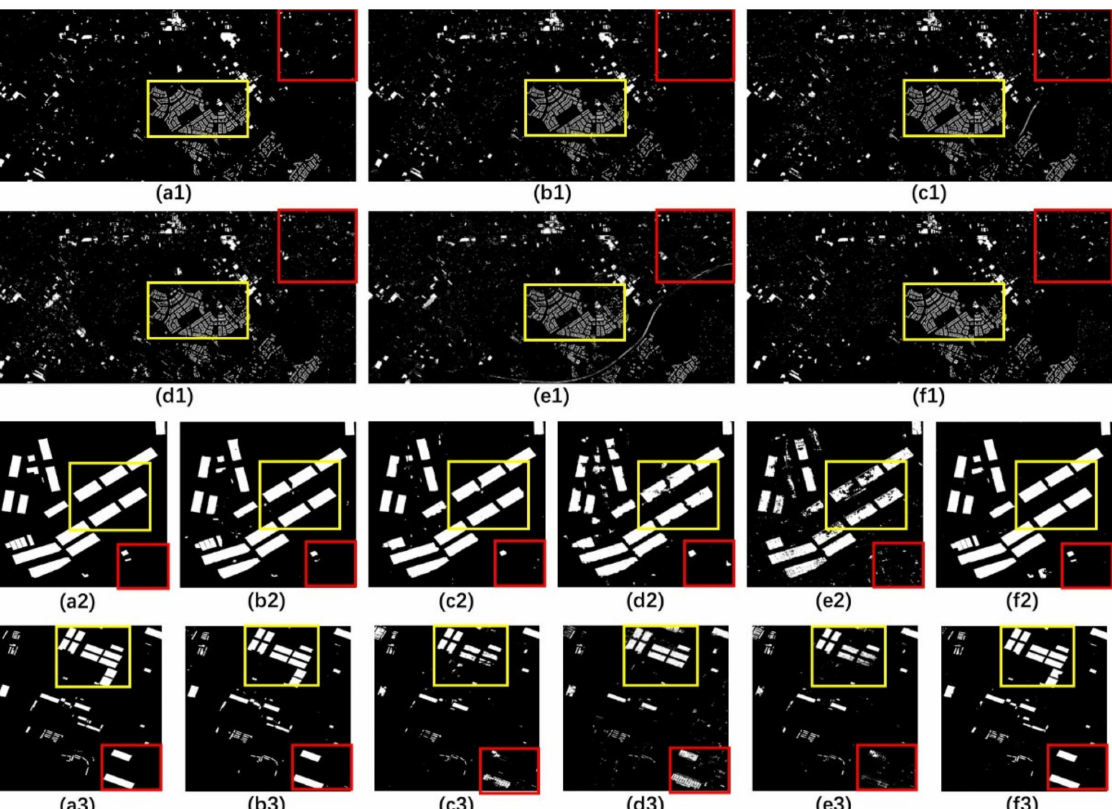
Figure 8. Visualization of the prediction results of each model. ( a ) Ground truth. ( b ) FCN. ( c ) UNet. ( d ) SegNet. ( e ) UNet++. ( f ) TDA-Net. Where 1 denotes WHU Building dataset, 2 denotes Beirut dataset, and 3 denotes Tianjin